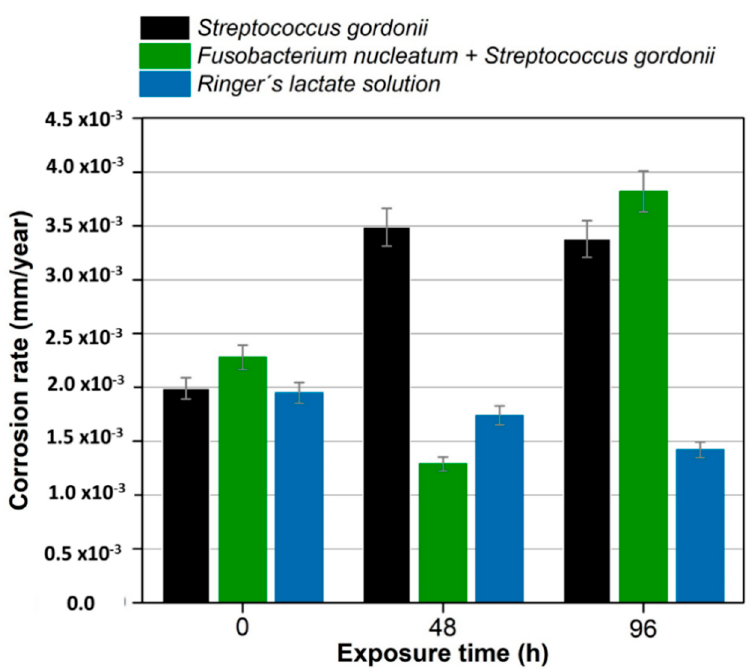
Figure 3. Corrosion rate of the Ti6Al4V alloy at 0, 48, and 96 h of exposure to Streptococcus gordonii , Fusobacterium nucleatum + Streptococcus gordonii , and Ringer´s lactate at 37 °C.